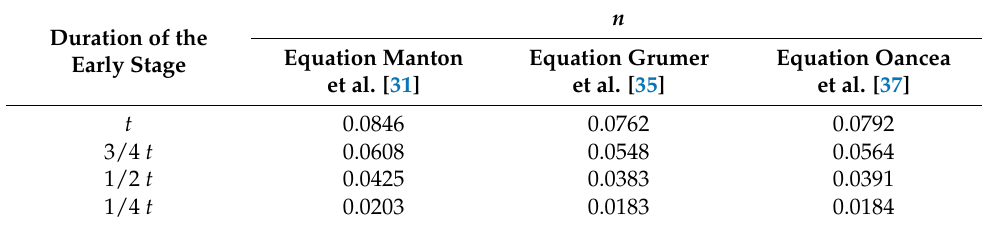
Table 3. The burnt mass fractions of stoichiometric CH 4 -N 2 O mixture diluted with 40 vol% N 2 , at atmospheric initial pressure and